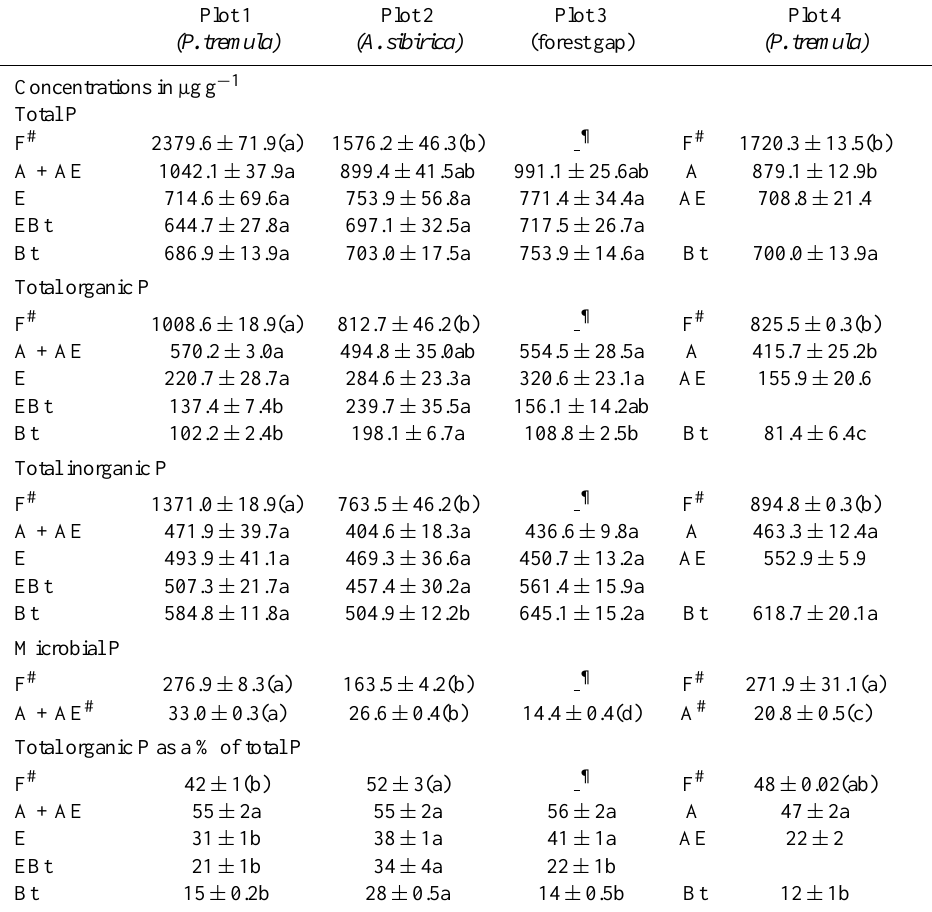
Table 5. Total, total organic, total inorganic and microbial P. Plot 1 Plot 2 Plot 3 Plot 4 (P.